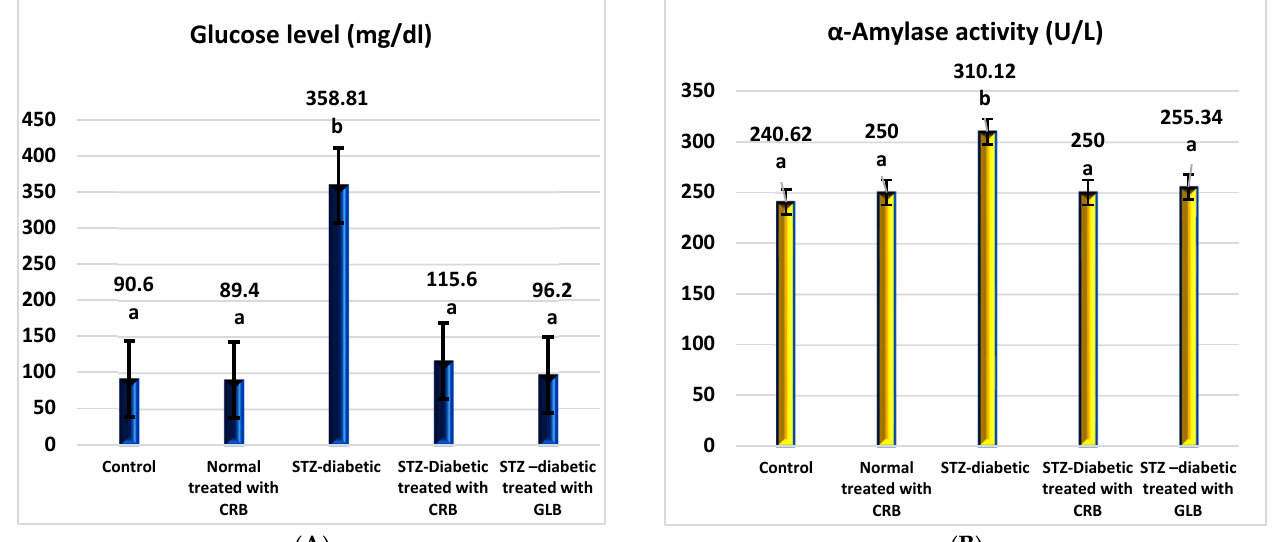
Figure 2. Effect of the n-butanol fraction of Colvillea racemosa total extract (CRB) oral administration on the pancreatic activity in diabetic STZ-treated rats: glucose ( a ) and α -amylase activity ( b ). Results are shown as means ± S.D. (measured in triplicate; n = 3). Means that have different letters are significantly different ( p < 0.05).